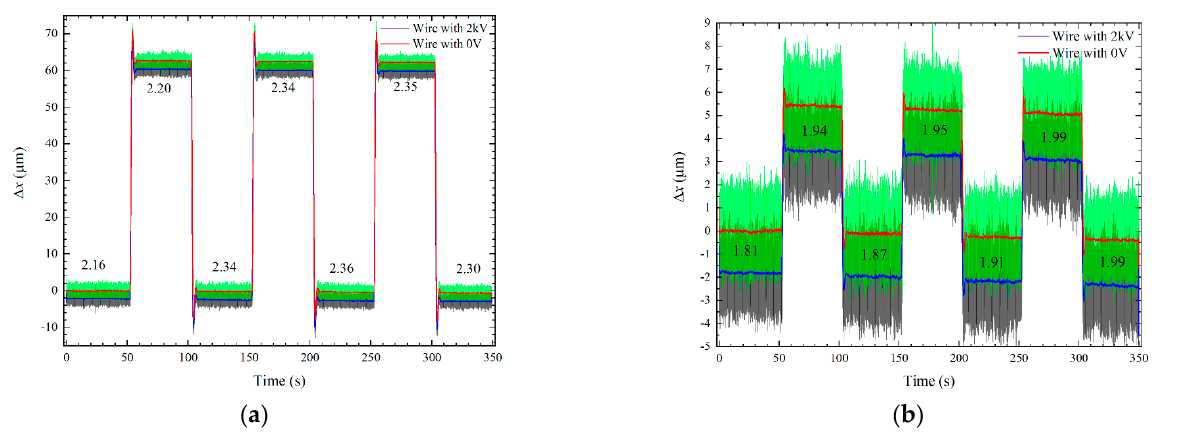
Figure 21. The arm displacement response to different thrust with 2 kV wire voltage. ( a ) 3 μ N, ( b ) 30 μ N.